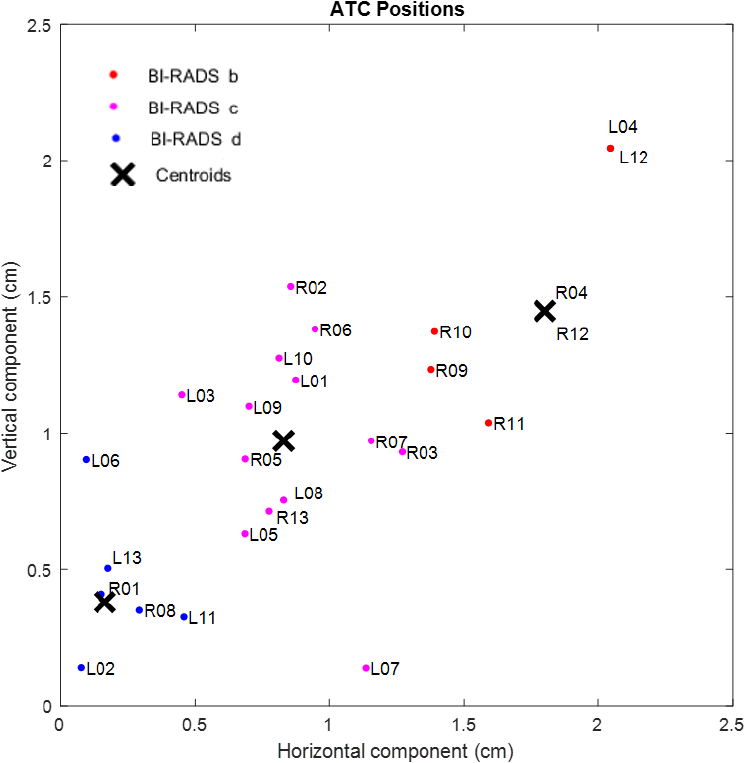
Figure 5. Achieved results applying K-means clustering.